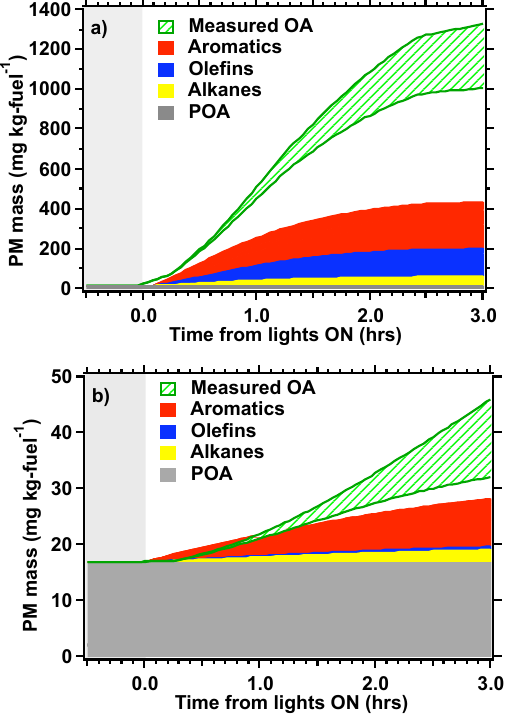
Fig. 10. Comparisons of predicted and measured SOA at (a) 4% engine load and (b) 85% engine load. Dashed area represents range of measured SOA estimates and accounts for uncertainty in wall- loss corrections. Different colored areas indicate contributions of aromatic, olefin, and alkane precursors to the predicted